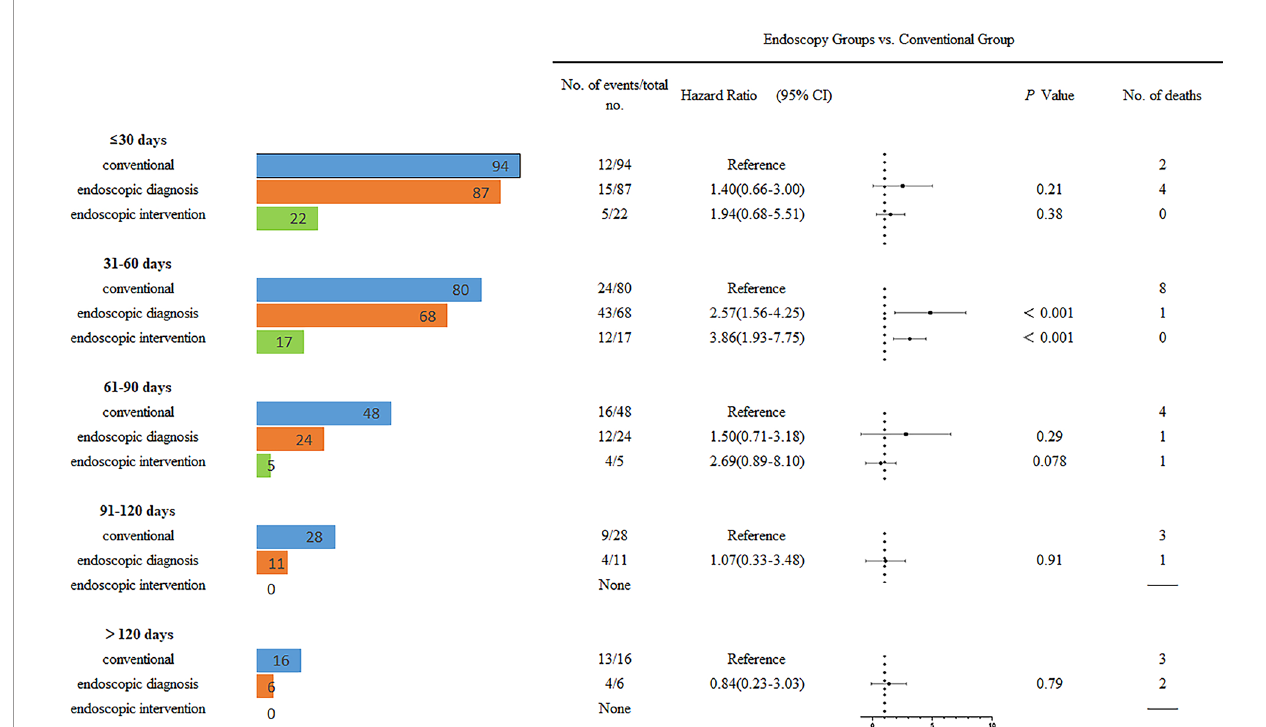
FIGURE 4 | Overall healing of patients with EAL based on landmark analysis and corresponding hazard ratios. The number of unhealed patients with EAL and the corresponding hazard ratios are shown at various time points for the groups. A total of 94 patients in the conventional group, 87 in the endoscopic diagnosis group, and 22 in the endoscopic intervention group; the corresponding numbers at 60 days were 48, 24, and 5, and the corresponding numbers at 90 days were 28, 11, and 0.